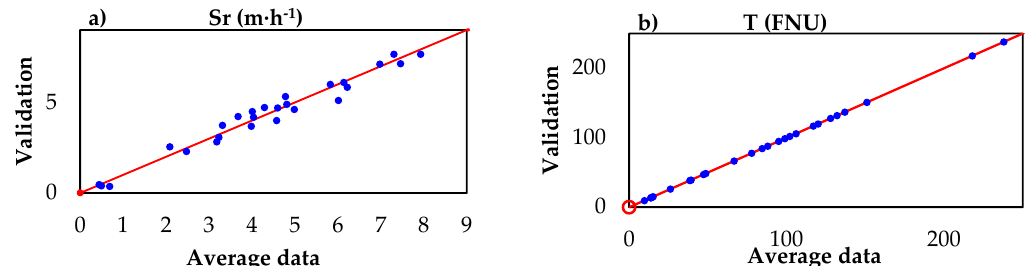
Figure 9. Comparison between validation and average data in the validation process for ( a ) Settling rate (Sr), ( b ) Turbidity